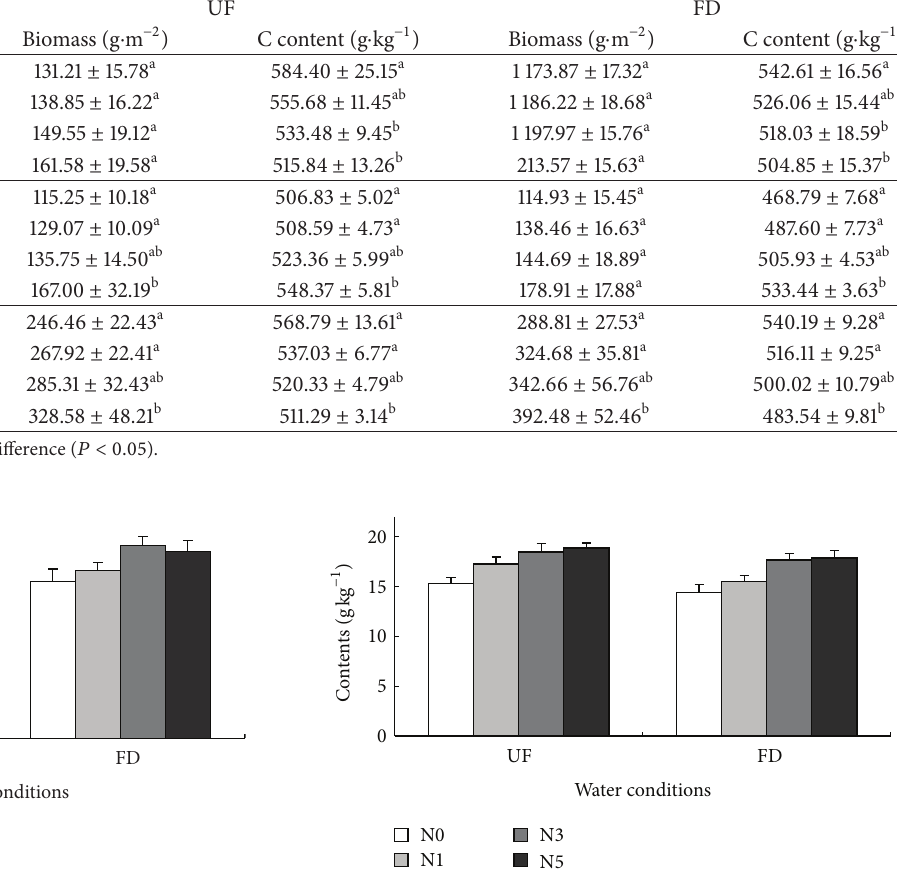
Figure 1: Effects of N-deposition on the leaf area of C. angustifolia . Figure 2: Effects of N-deposition on the leaf N content of C. angustifolia